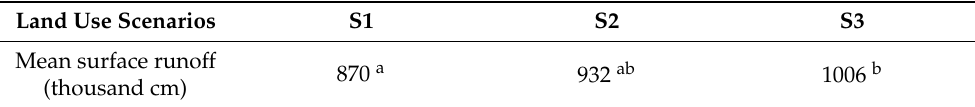
Table 4. Testing influence of land use change scenarios on surface runoff.